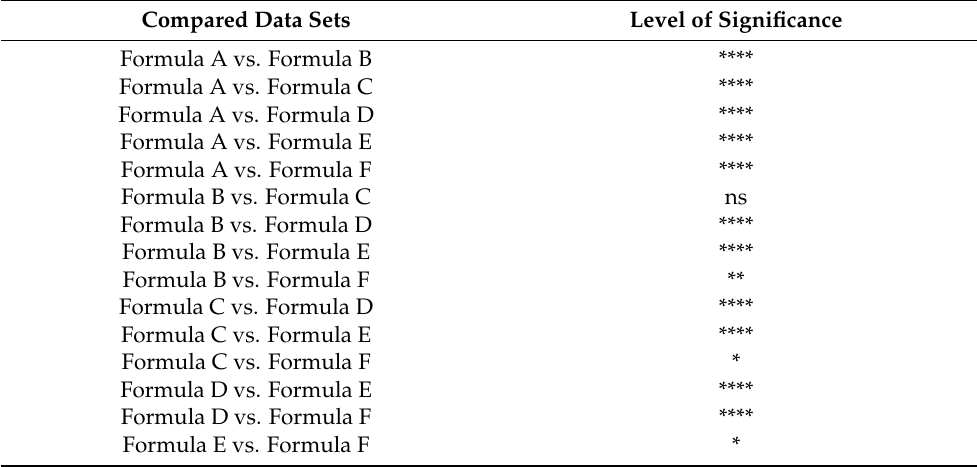
Table 8. Results of Tukey’s multiple comparison test generated by the data of quercetin diffusion